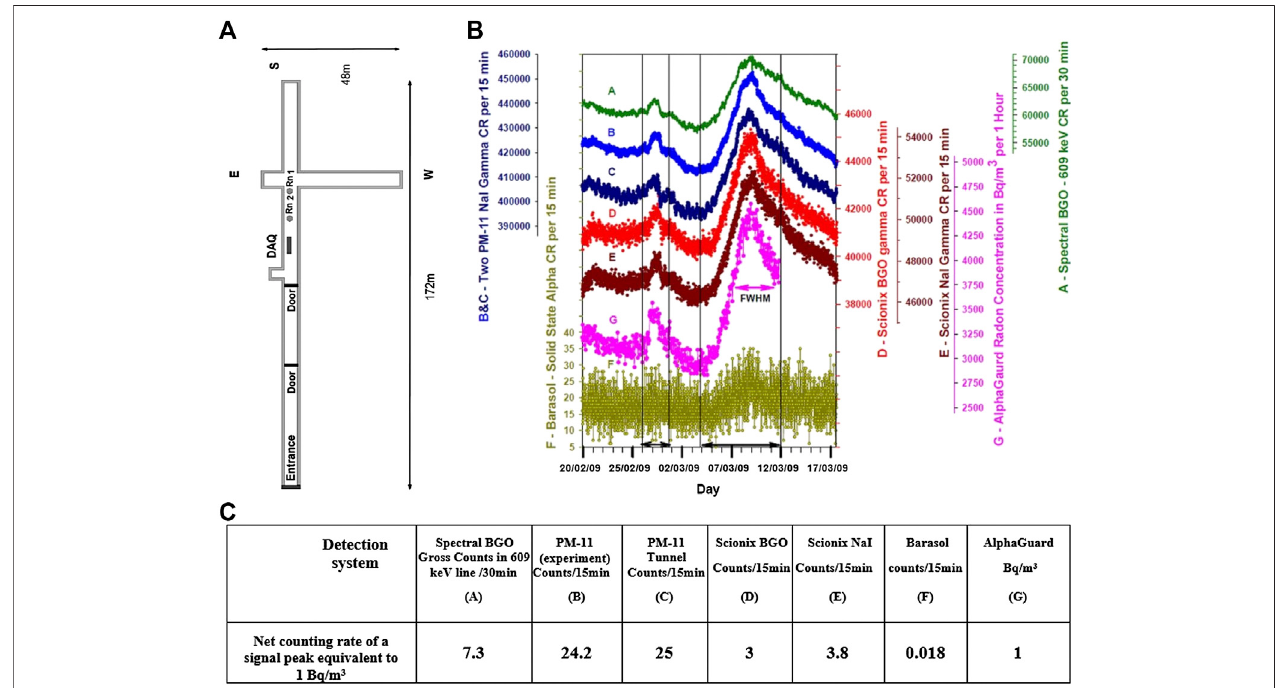
FIGURE 4 | (A) Radon setup in the Amram tunnel. (B) Variations of radon from 20 February to March 18, 2009, as measured simultaneously by seven different radonsensors. The AlphaGUARD system (G) ,whichstoppedmeasuringonMarch12,presentstheradonconcentrationinBq/m 3 per60 minmeasurementcycletime, whiletherestpresenttheCR(CountingRate)per30 min (A) ,orper15 min (B – F) .Tworadonanomaliesoccurred:asmall(inamplitude)andshort(intime)oneforalmost two days from 26 to28 February and apredominant one from 4 to March 18, 2009. (C) a conversion scale that enable to evaluate the counting rate, CR, per 15 or 30 min of the various detectors sensors (A – F) at peaks in Bq/m 3